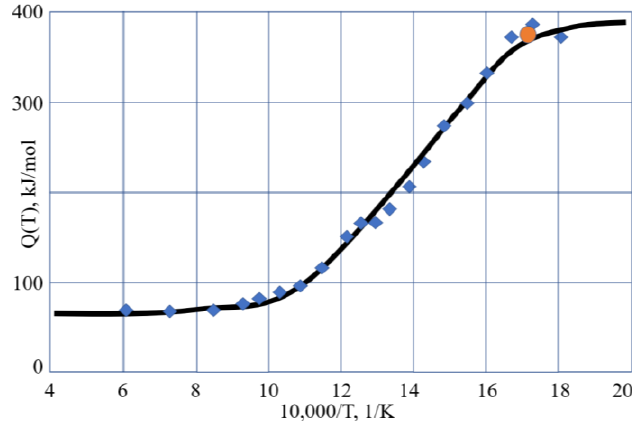
Figure 1. The activation energy of the viscosity Q(T) for vitreous and molten B 2 O 3 . Experimental data are taken from [23]. The orange circle indicates the position of glass transition temperature T g = 580 K.